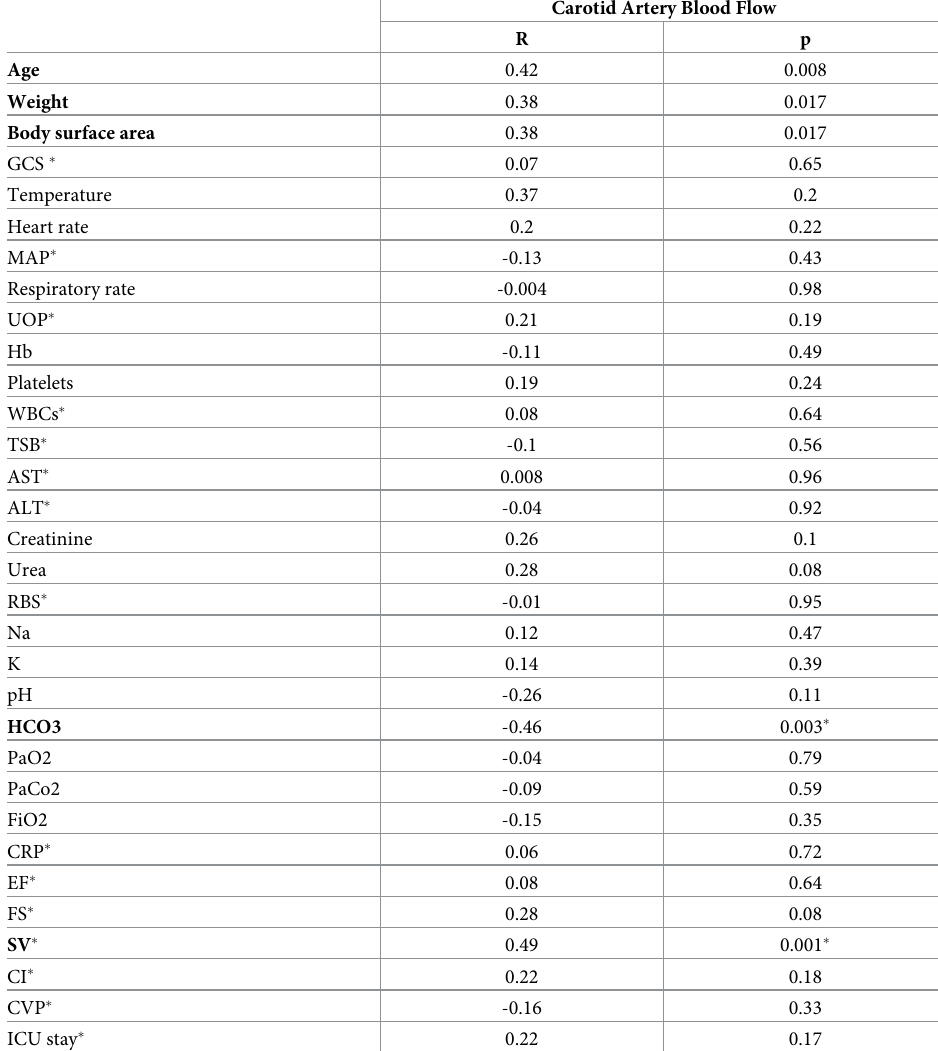
Table 2. Correlation between CBF and various clinical and laboratory parameters.